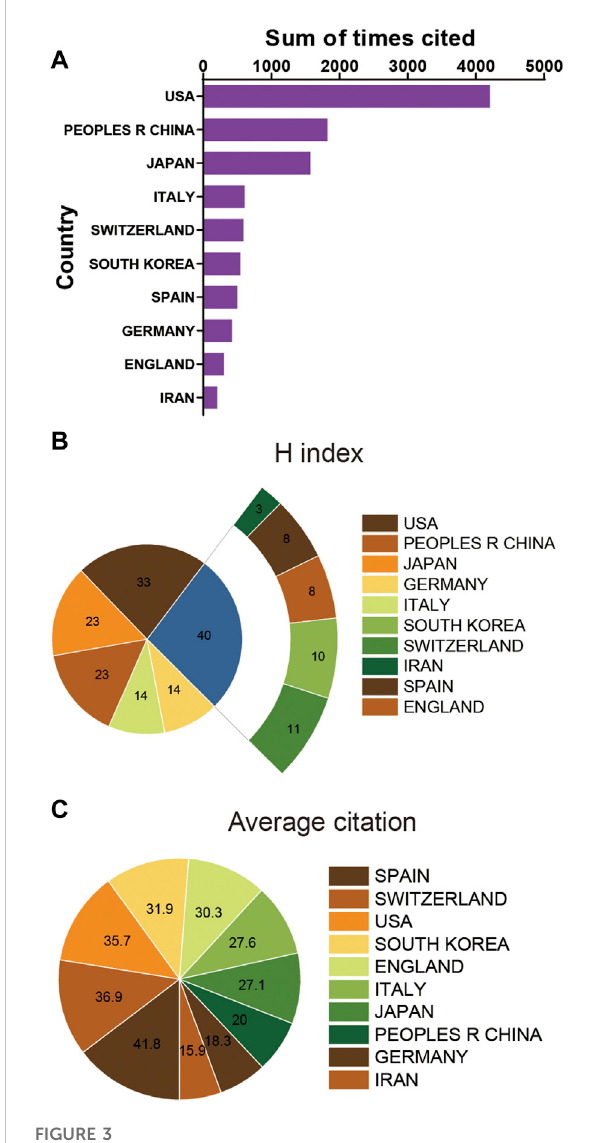
FIGURE 3 (A) The top 10 countries/regions of total citations related to stem cells for meniscal regeneration. (B) The top 10 countries/regions of the publication H-index related to stem cells for meniscal regeneration. (C) The top 10 countries/regions of the average citations per publication related to stem cells for meniscal regeneration.